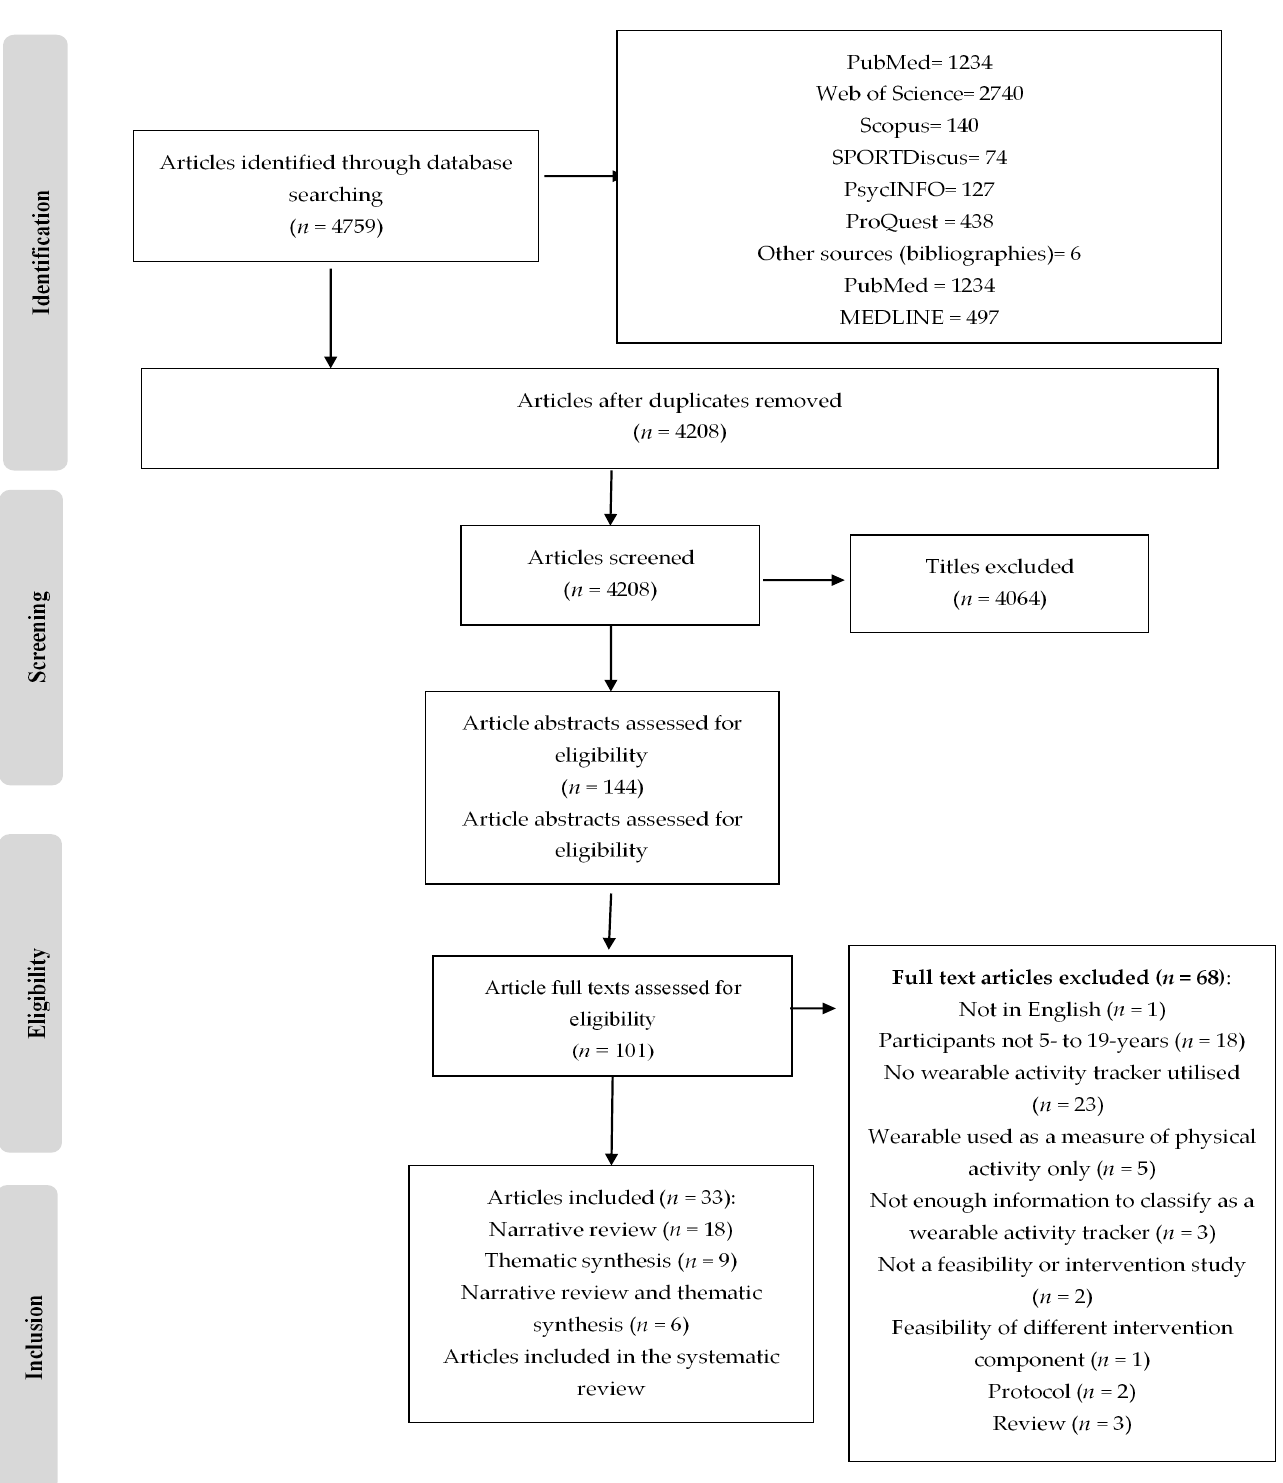
Figure 1. Preferred Reporting Items for Systematic Reviews and Meta-Analyses (PRISMA) flow diagram illustrating the review process.